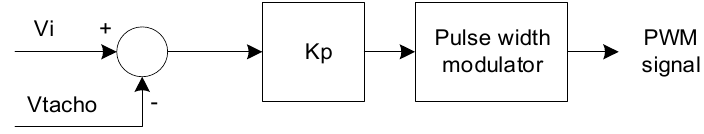
Fig. 3. Block diagram for the proportional